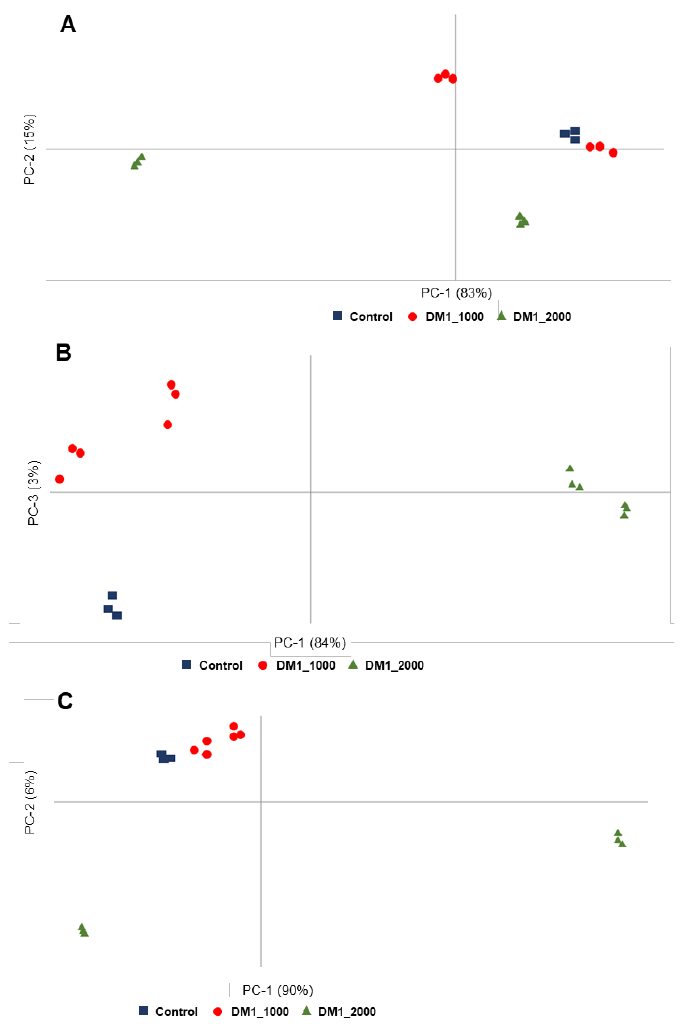
Figure 2. PCA scores profile of DM1-derived fibroblasts and control. ( A ) 3000-2800 cm −1 region. ( B ) 1800-1500 cm −1 region. ( C ) 1200-900 cm −1 region.